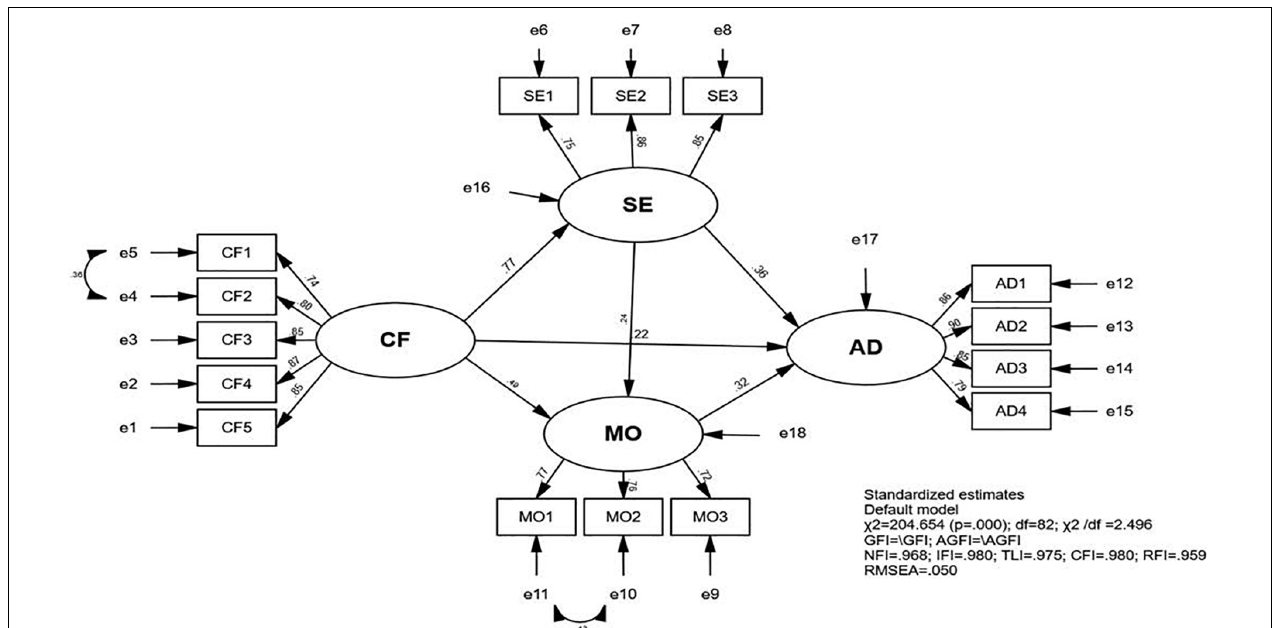
FIGURE 2 | The result of path coefficients of the final model.